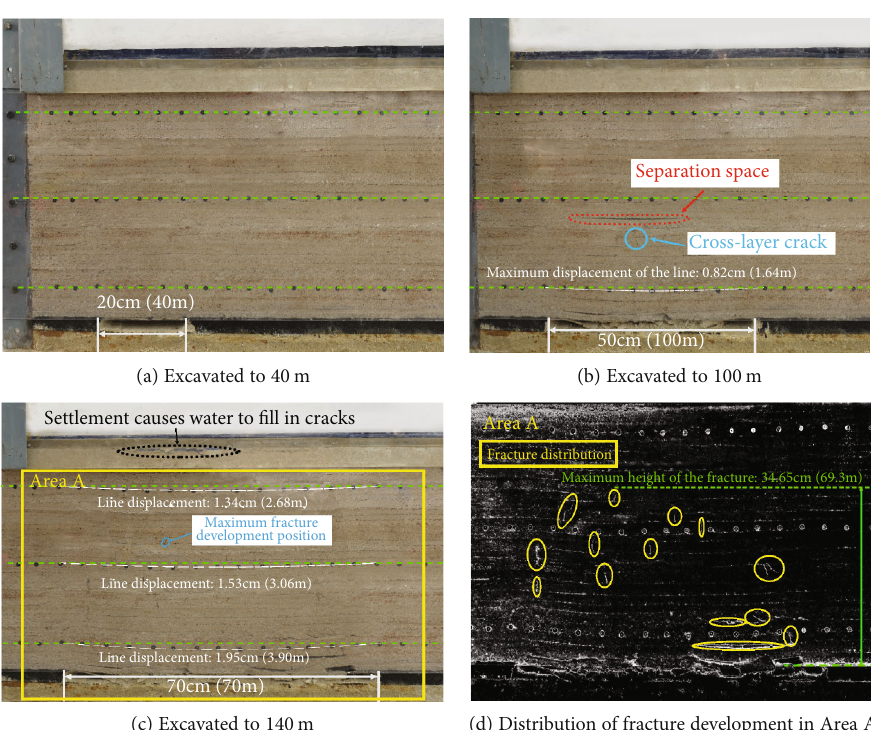
Figure 7: The experimental results of mining